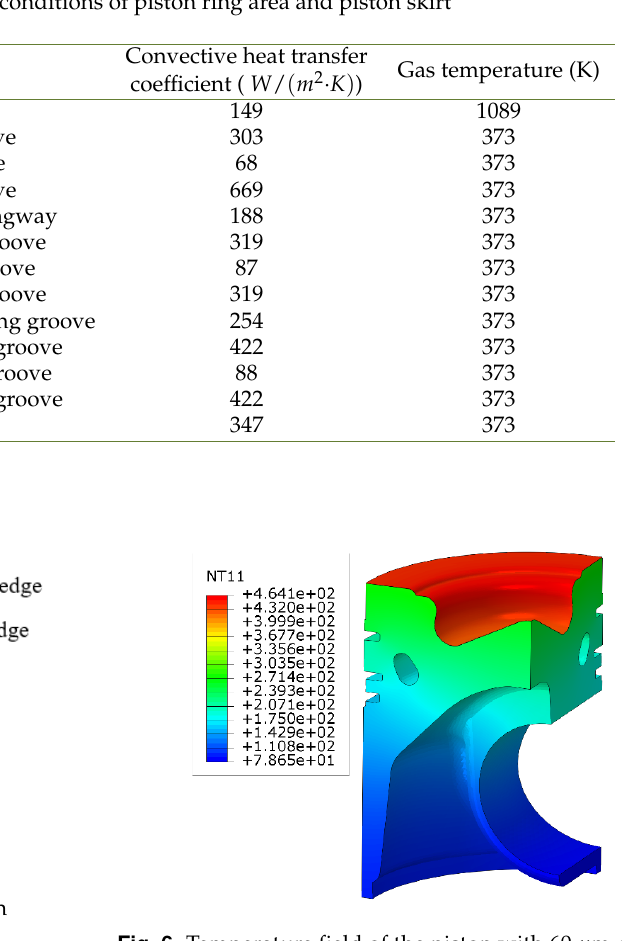
Fig. 6. Temperature field of the piston with 60 µ m coating